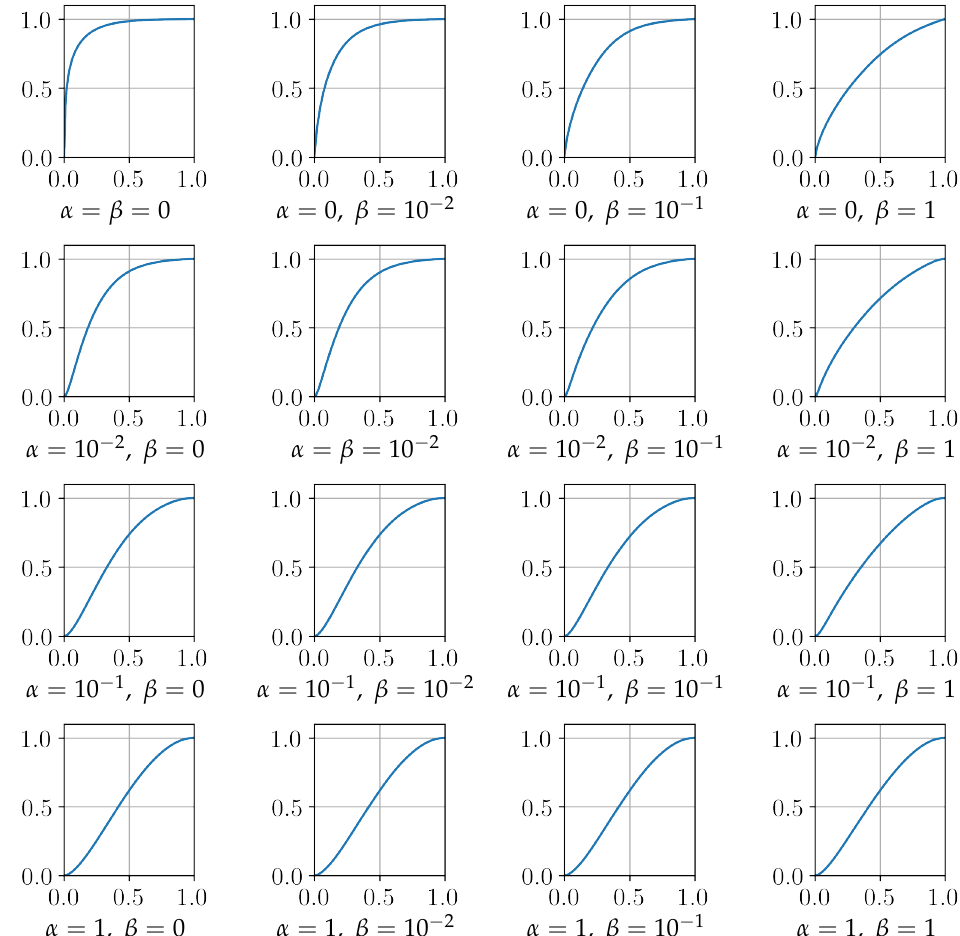
Figure 1. Phase field distribution for ( α , β ) ∈ { 0,10 − 2 ,10 − 1 ,1 } 2 (horizontal axis—polar radius r , vertical axis—phase field value φ = φ ( r ) ).